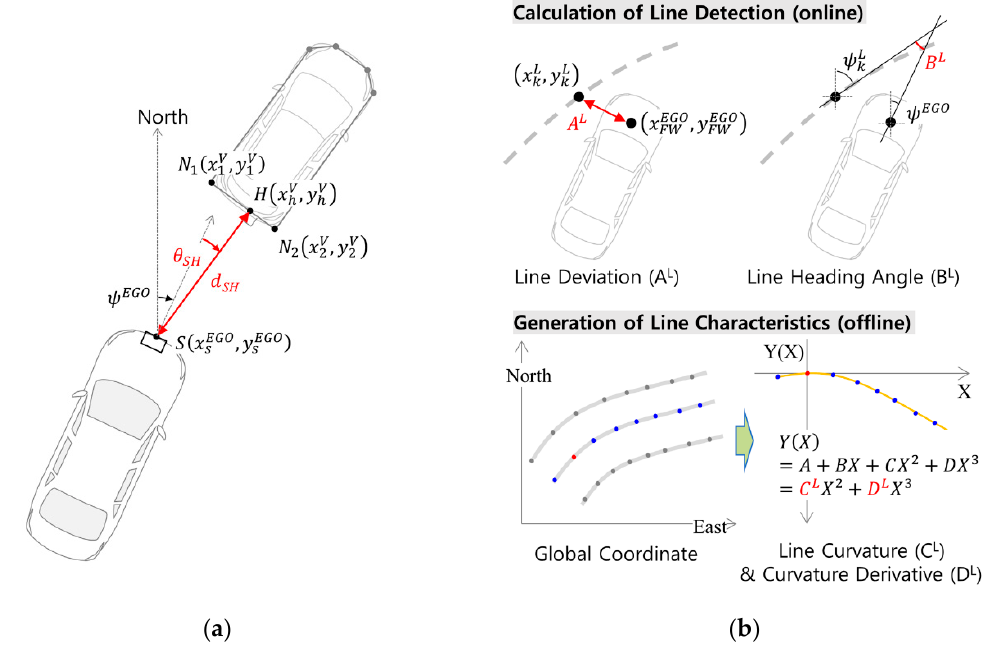
Figure 4. ( a ) Calculation of radar detected object information; ( b ) Calculation of road line information by the vision sensor.